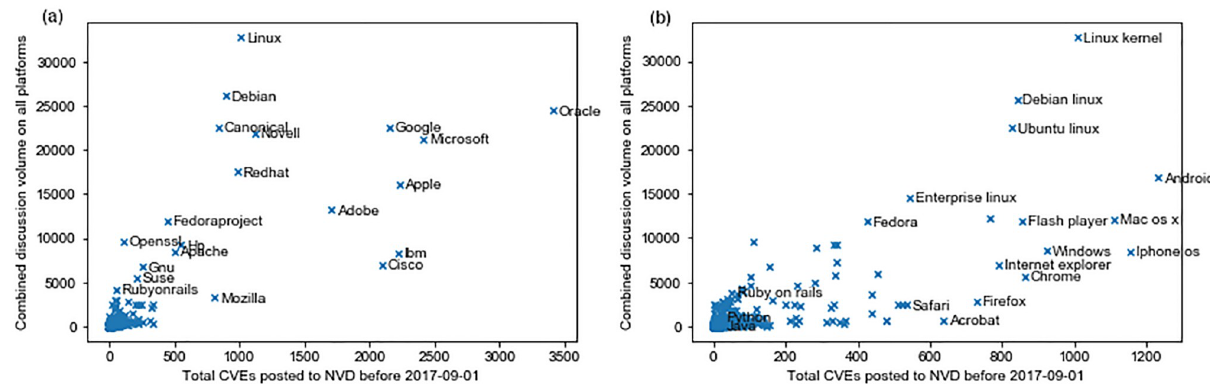
Fig 3. Discussion volume on social media vs vulnerabilities published to NVD for different vendors and products. (a) Vendors (b) Products.